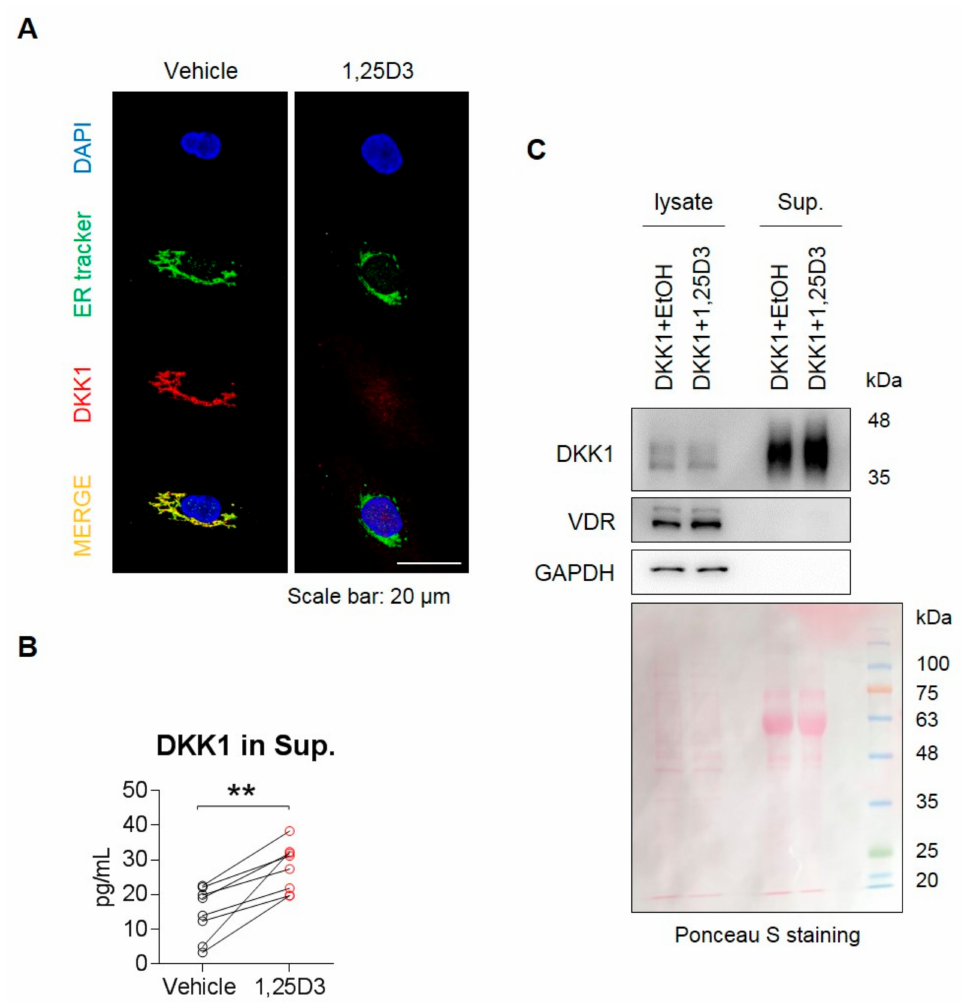
Figure 4. 1,25D3 stimulates secretion of DKK1 protein in osteoblasts. ( A ) Osteoblasts were treated with 20 nM 1,25D3 for 24 h and stained with ER tracker (green), anti-DKK1 (red), and DAPI (blue). Scale bar is 20 µ m. Representative data are shown ( n = 3). ( B ) Osteoblasts were treated with 20 nM 1,25D3 for 24 h, then the culture supernatant was collected and secreted DKK1 protein was measured in the supernatant using ELISA. ** p < 0.01 (mean ± SD; n = 6). ( C ) Osteoblasts were transfected with 2 µ g DKK1 plasmid for 48 h, and then treated with 1,25D3 for 24 h. Proteins secreted in the cell supernatant by 1,25D3 stimulation were collected, precipitated by trichloroacetic acid (TCA) and detected by SDS-PAGE / immunoblotting. Ponceau S staining was used as culture supernatant controls. Representative data are shown ( n =